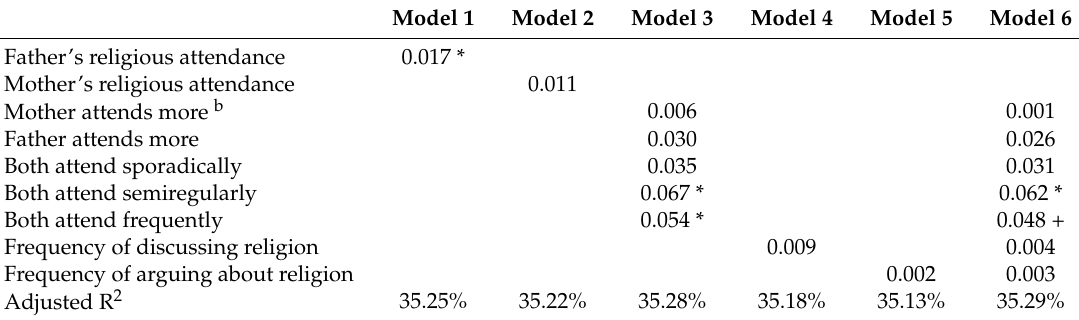
Table 6. Unstandardized coefficients predicting children’s approaches to learning (teachers’ ratings, n = 10,720) a .